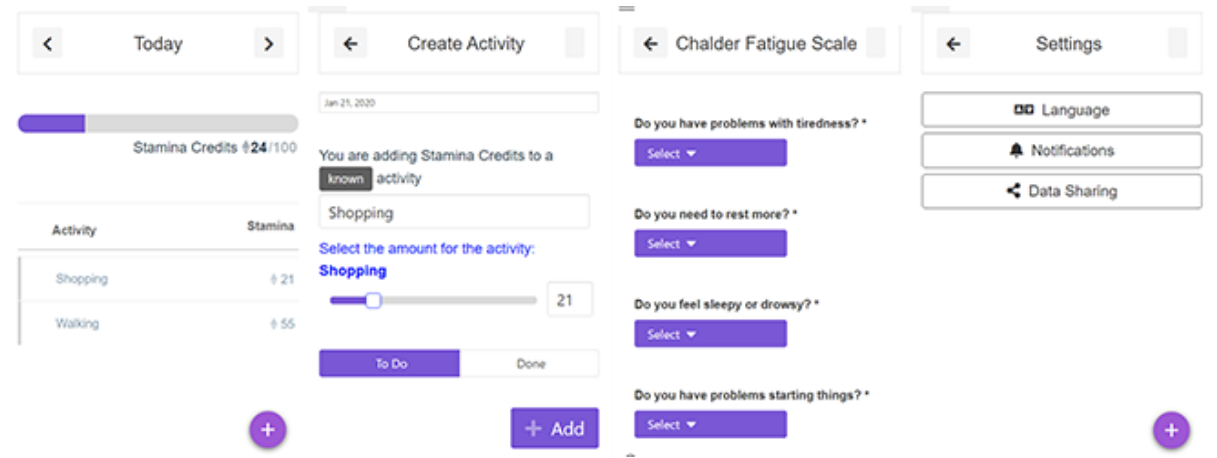
Figure 1. More Stamina screenshots.